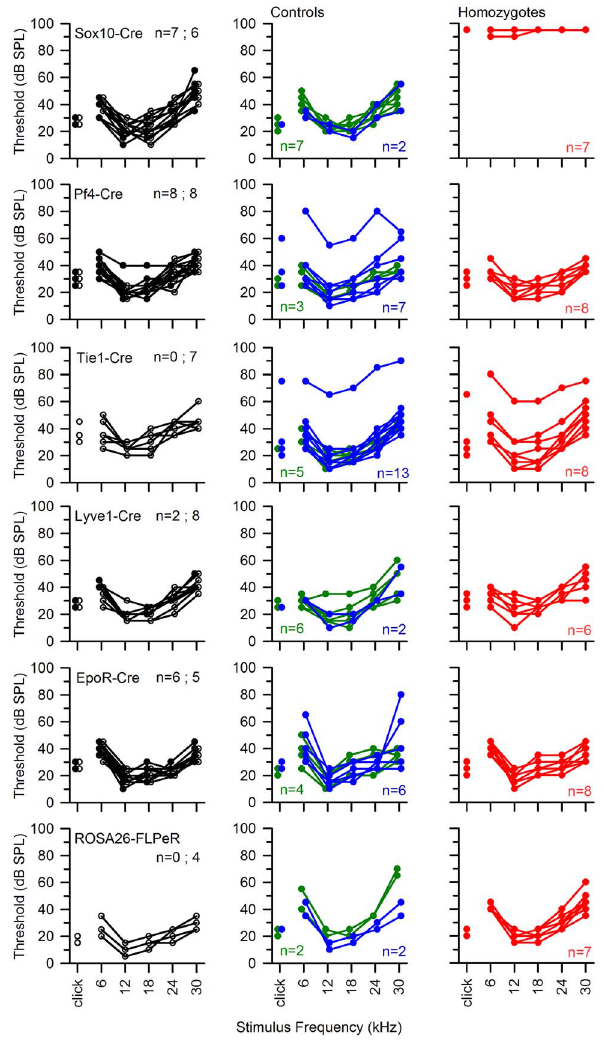
Figure 10. ABR thresholds of mice with Spns2 conditionally inactivated in different tissues. ABR thresholds of individual mice are shown. All Cre driver lines showed normal thresholds (left column, in black. n=number of wildtype; number of mice carrying Cre). Most control littermates had normal responses (middle column: heterozy- gotes in blue; wildtypes in green). Homozygous Spns2 tm1d mutants (red) carrying the relevant Cre alleles are shown in the right column. Spns2 tm1d homozygotes carrying the Sox10-Cre allele had raised thresholds (top right), but the other four Cre lines had normal thresholds. The bottom row shows equivalent threshold data for the Spns2 tm1c allele and the Flp recombinase line used to generate this allele, again showing normal thresholds. There were three exceptions of individuals with raised thresholds (one heterozygote each in Pf4-Cre cross and Tie1-Cre cross, one homozygote in Tie1-Cre cross), which we believe probably carry an independent mutation causing the impair- ment (subject to ongoing positional cloning